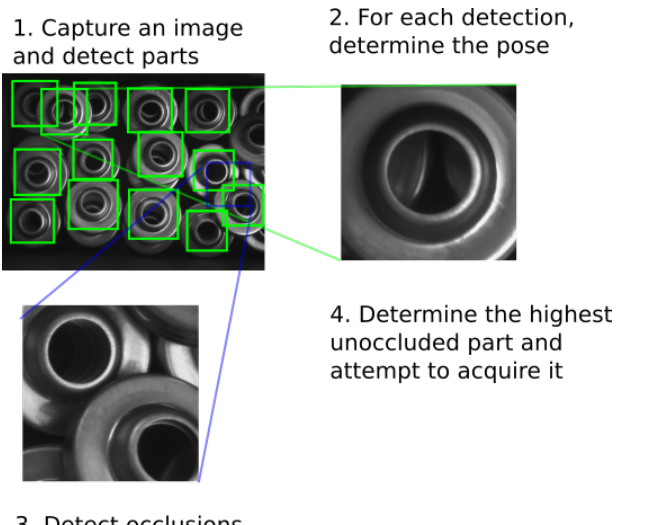
Figure 7. The developed framework consists of a part detector, a pose estimator, and an occlusion